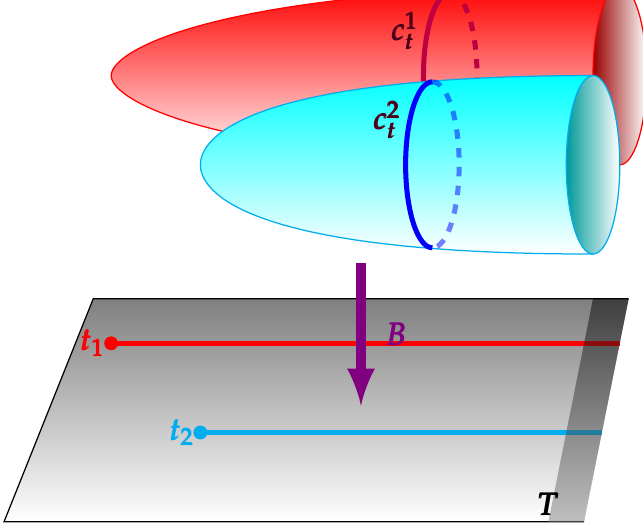
γ log B . Figure 22. Thimbles drawn above the plane of t = γ log B − −